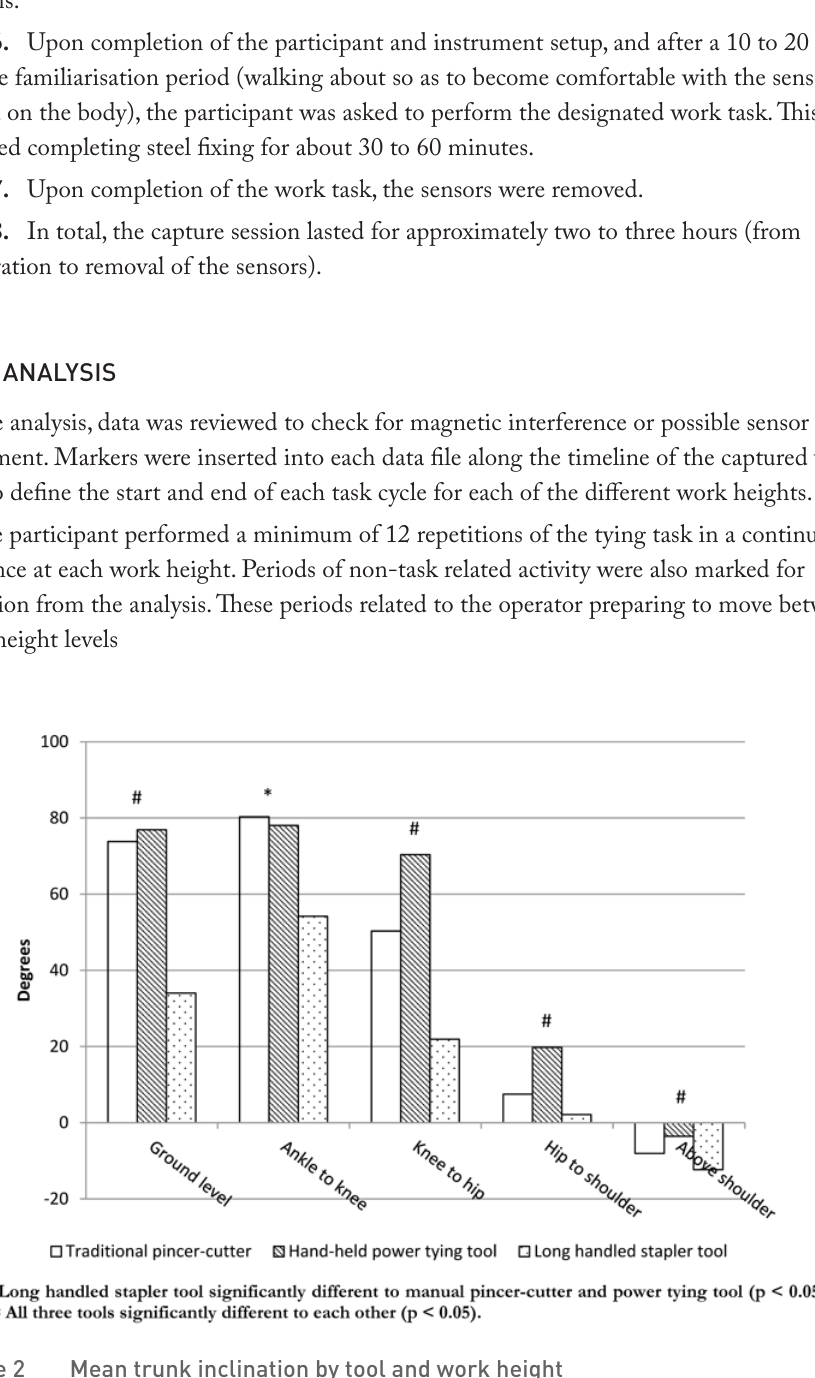
Figure 2 Mean trunk inclination by tool and work